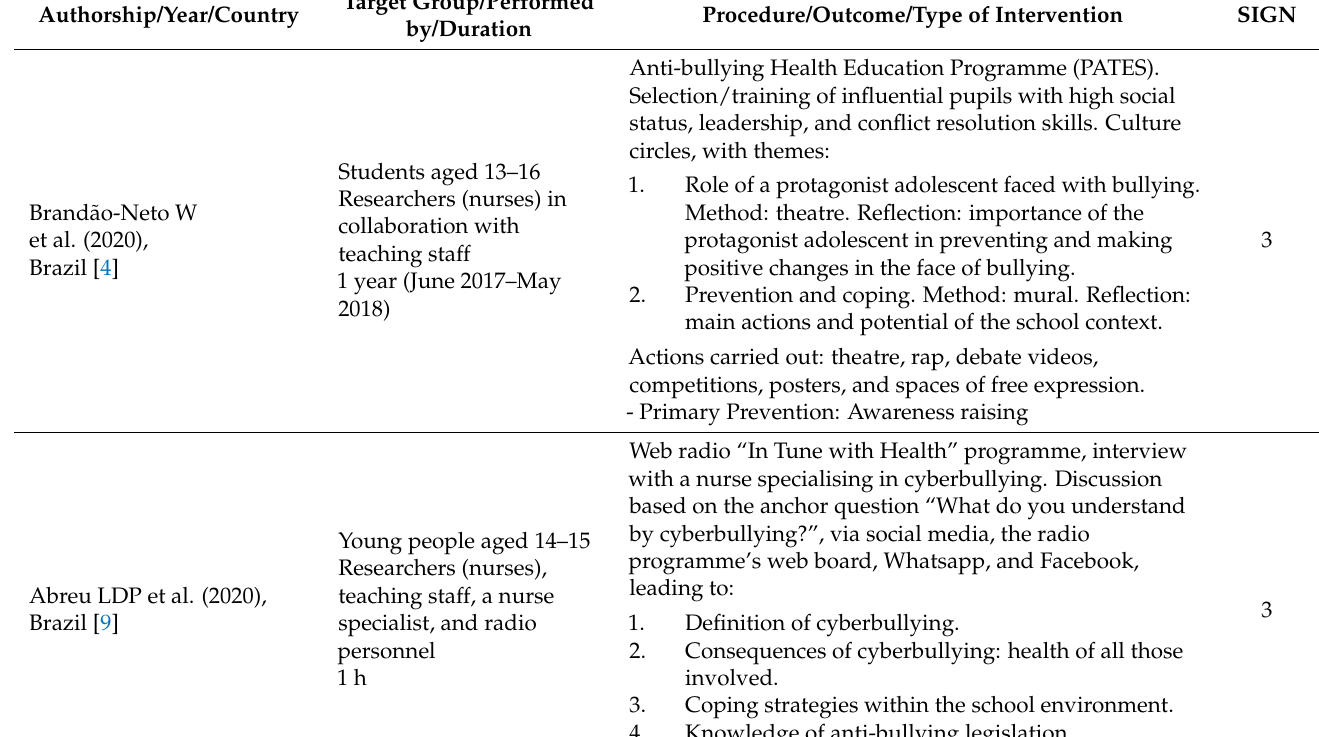
Table 1. Synthesis of interventions from qualitative studies and Scottish Intercollegiate Guidelines Network (SIGN) levels of